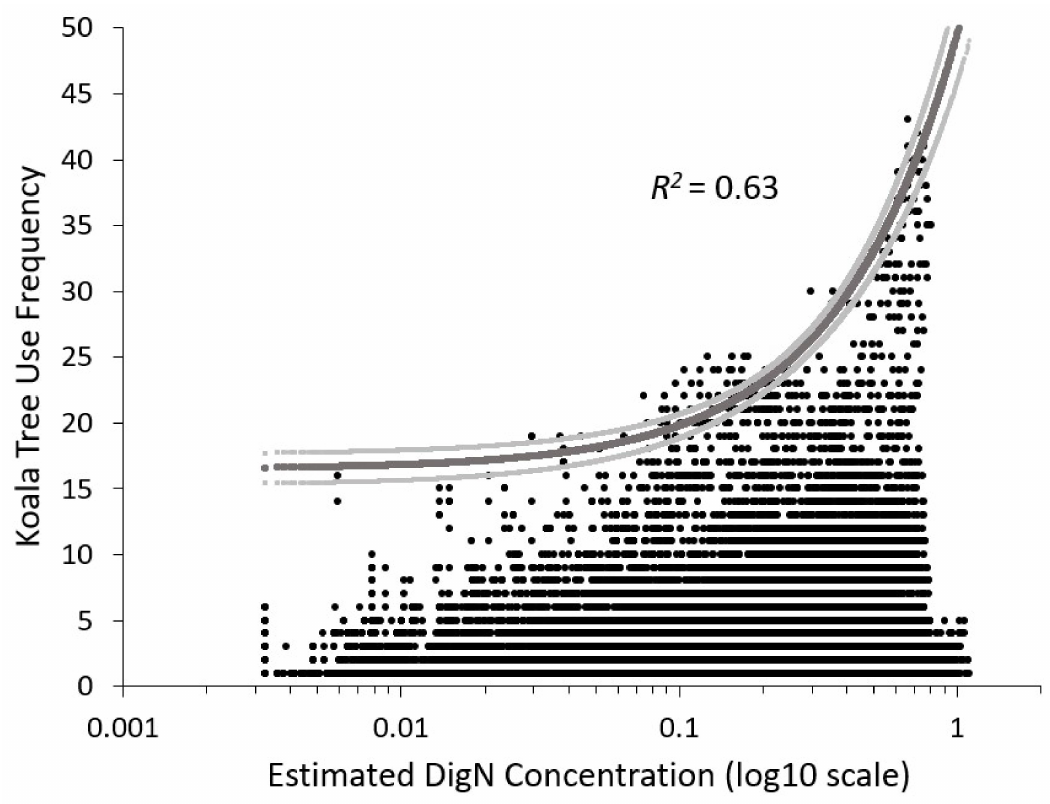
Figure 8. Correlation between koala tree use frequency (as mapped in the field in 2010 and 2011) and log10 transformed estimated DigN concentration (% dry matter) from the WV2 image of 2012 with quantile regression fitted line for the 0.999 quantile (dark grey) and 95% confidence bounds (light